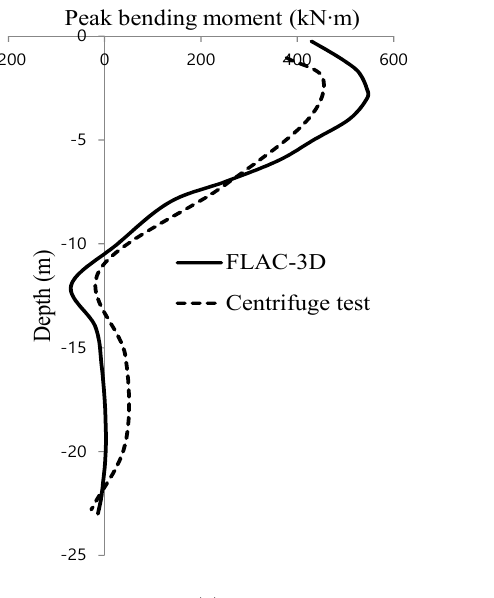
Figure 9. Measured and calculated peak bending moment profiles (Model 1, Nisqually earthquake): ( a ) Nisqually, 0.13 g; ( b ) Nisqually, 0.51 g.